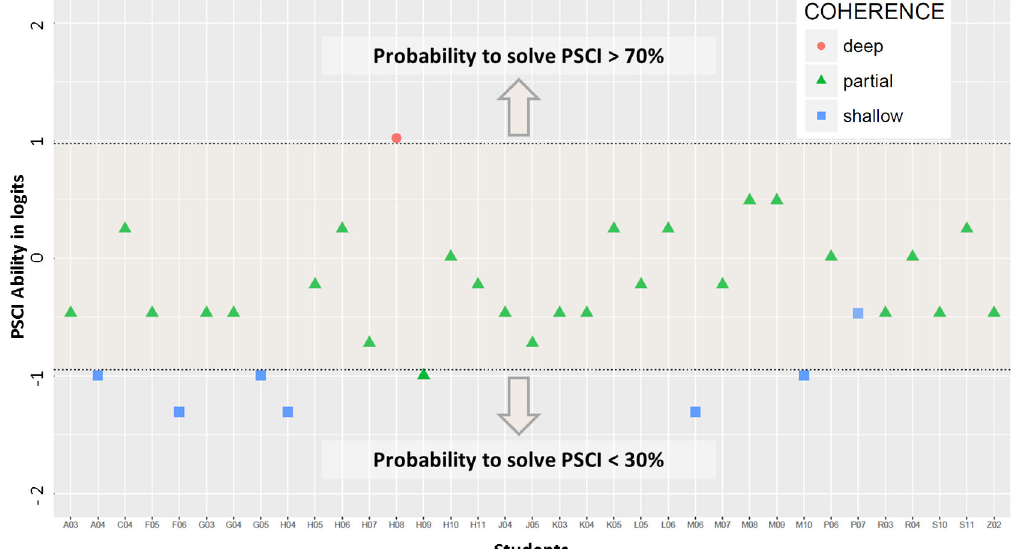
FIG. 9. Quick diagnostic chart. The name codes of the students in postinstruction testing are listed on the horizontal axis. Each student is represented by a symbol. The shape and color of the symbols denote the knowledge-coherence category. The vertical coordinate gives ˆ θ the PSCI-estimated ability parameter . The highlighted band represents the 95% confidence interval of a zero (median) ability. The persons located below the highlighted band have less than 30% chance to solve correctly the entire PSCI-BETA. The persons located above the highlighted band have a chance greater than 70% to solve correctly the